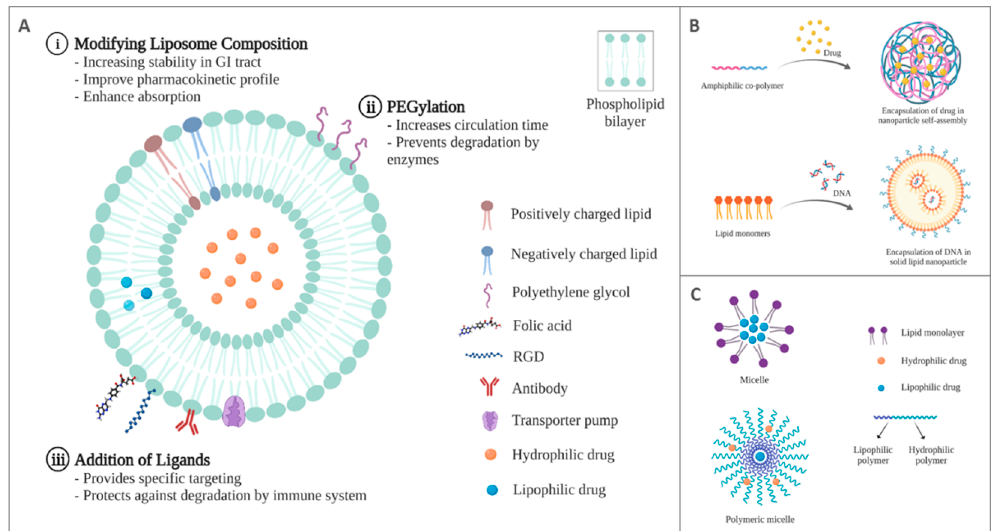
Figure 3. Schematic diagram of currently used drug delivery systems for oral delivery of peptides. ( A ). Liposome with possible physicochemical modifications: (i) Lipid composition of liposomes can be modified to include varying ratios of positive, negative, and neutral phospholipids, (ii) PEGylated phospholipids increase steric stability, (iii) Ligands such as antibodies, carbohydrates, and proteins can be added to the surface of liposomes for stability or specific targeting of a delivery system; ( B ). Self-assembled and solid lipid nanoparticles; ( C ). Micelle and polymeric micelle.